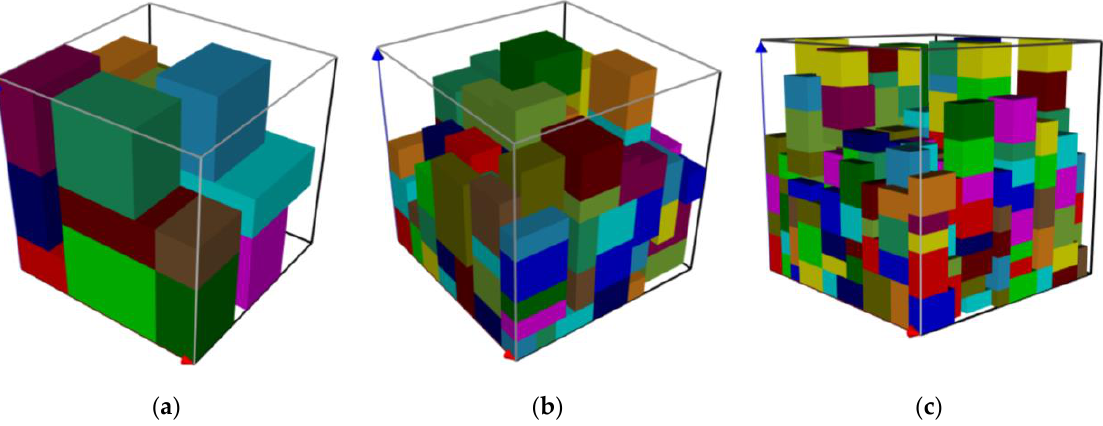
Table 6. The packing results with different bin sizes.